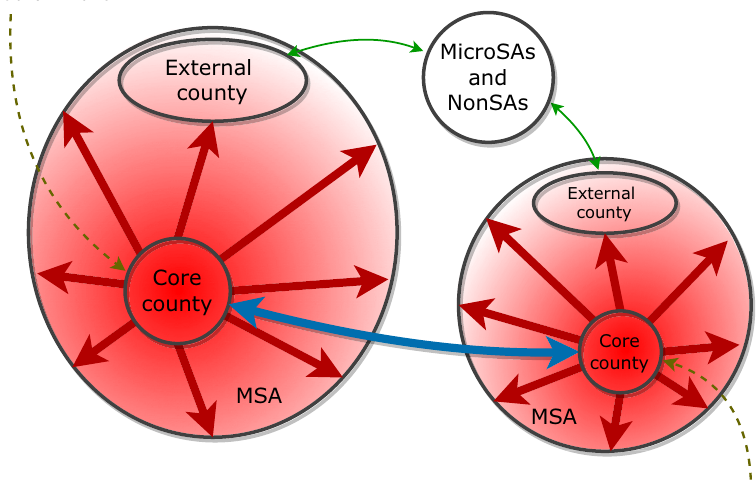
Fig. 1 | Schematic representation of the dominant migratory trends that con- tribute to the heterogeneous population growth of cities. Core counties are morelikely to receive in fl ows from core counties of other cities thanfrom external counties (blue arrows). Flows to and from microand non-statistical areasaremore likely to be found at the external counties of a city (green arrows). Intra-city fl ows (redarrows)indicatevectorsofredistributionofpeoplewithinthecity,andhavean outwards radial direction: people move from central counties with larger